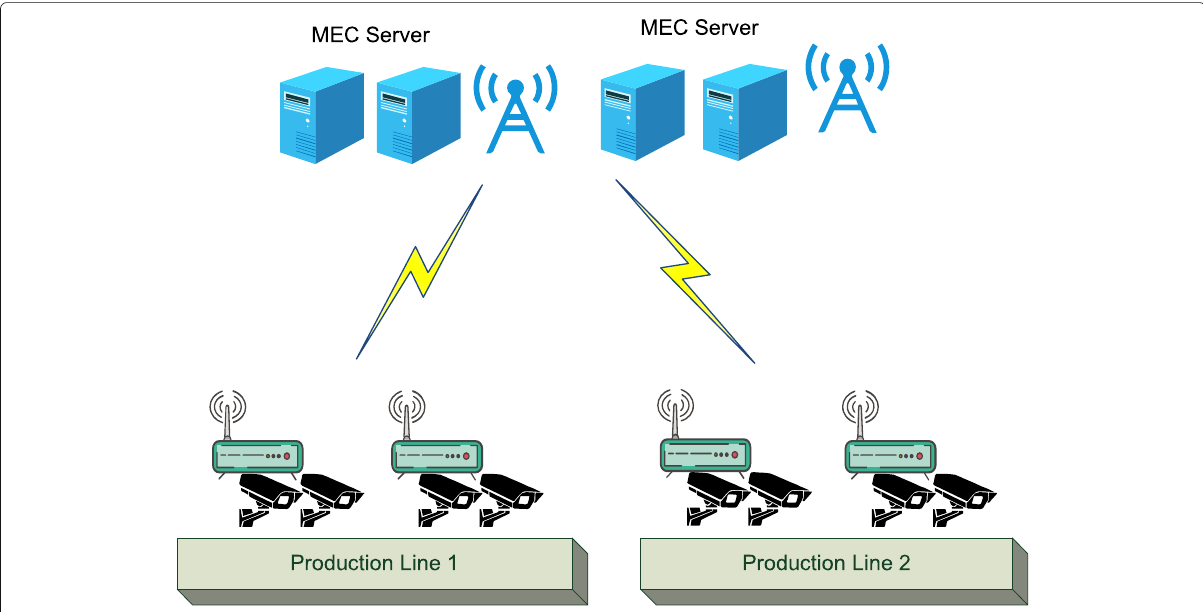
Fig. 1 Edge computing scenarios in 5G Industrial Internet of Things environment